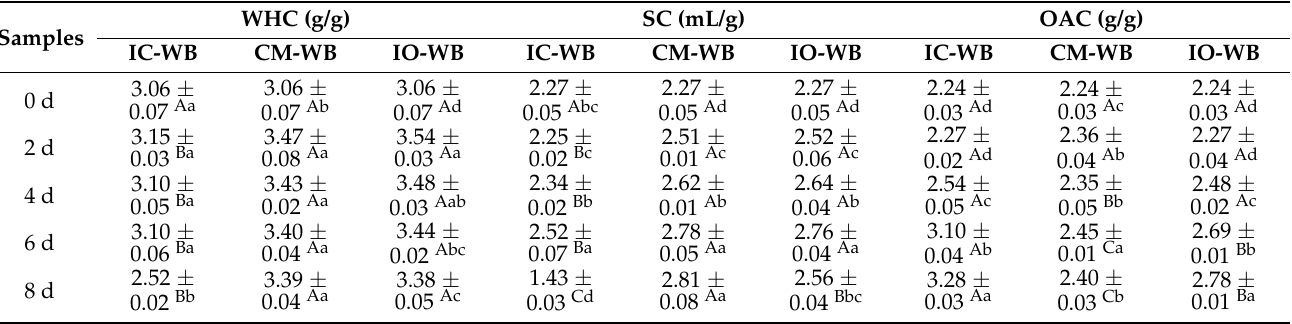
Figure 2. Changes of nutritional compounds in fermented wheat brans. ( A ) Total flavonoid content (TFC), ( B ) total phenolic content (TPC), ( C ) alkylresorcinols content (ARC) and ( D ) pH value. Different lowercase letters indicate significant differences at p < 0.05 in terms of fermentation time. Different capital letters indicate significant differences at p < 0.05 in terms of microorganisms. IC-WB, Isaria cicadae Miq. fermented wheat bran; CM-WB, Cordyceps militaris fermented wheat bran; IO-WB, Inonotus obliquus fermented wheat bran. Table 1. Water holding capacity (WHC), swelling capacity (SC), and oil absorption capacity (OAC) of fermented wheat brans at different fermentation times.